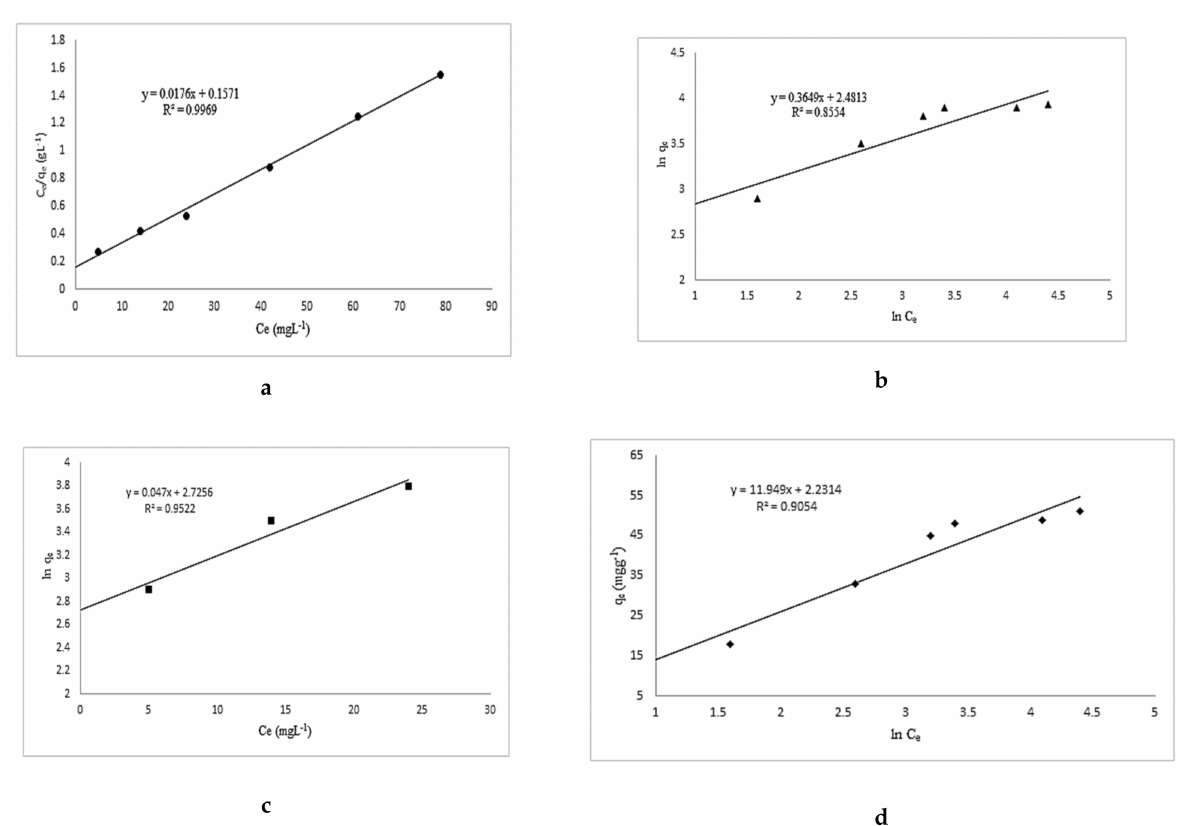
Figure 4. Adsorption isotherm plots of the CIPRO adsorption on the mango Fe 3 O 4 /C